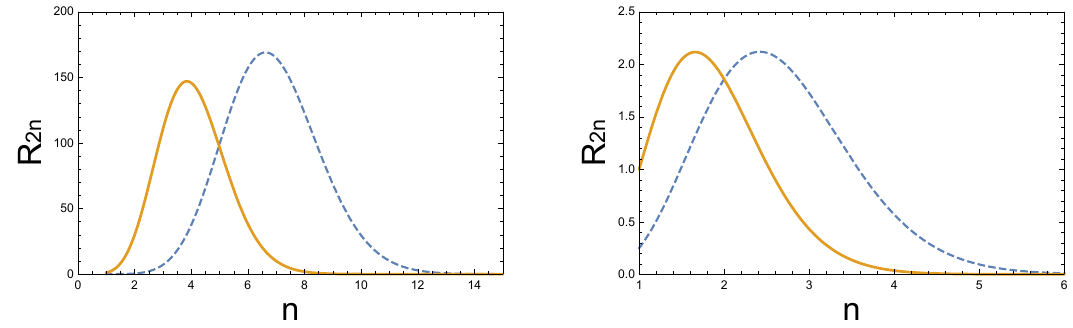
Figure 7. The Γ 2 n / Γ 2 ratio as a function of n calculated according to Equations (11) and (12). The left figure is for zero binding energy and the right figure for E b ∼ m . The solid curves represent the calculation with the interference factor and the dashed curves the one without the factor. In order to have the two curves at the same scale, the no interference ratios had to be divided by 250 left and by 4